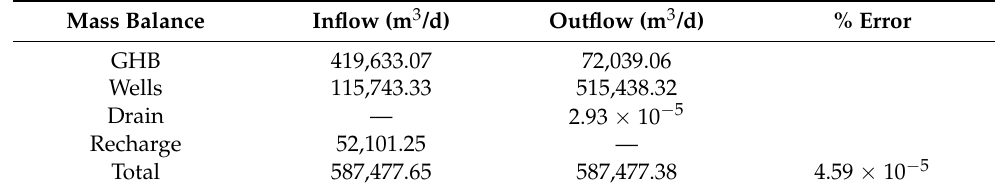
Table 3. Model mass